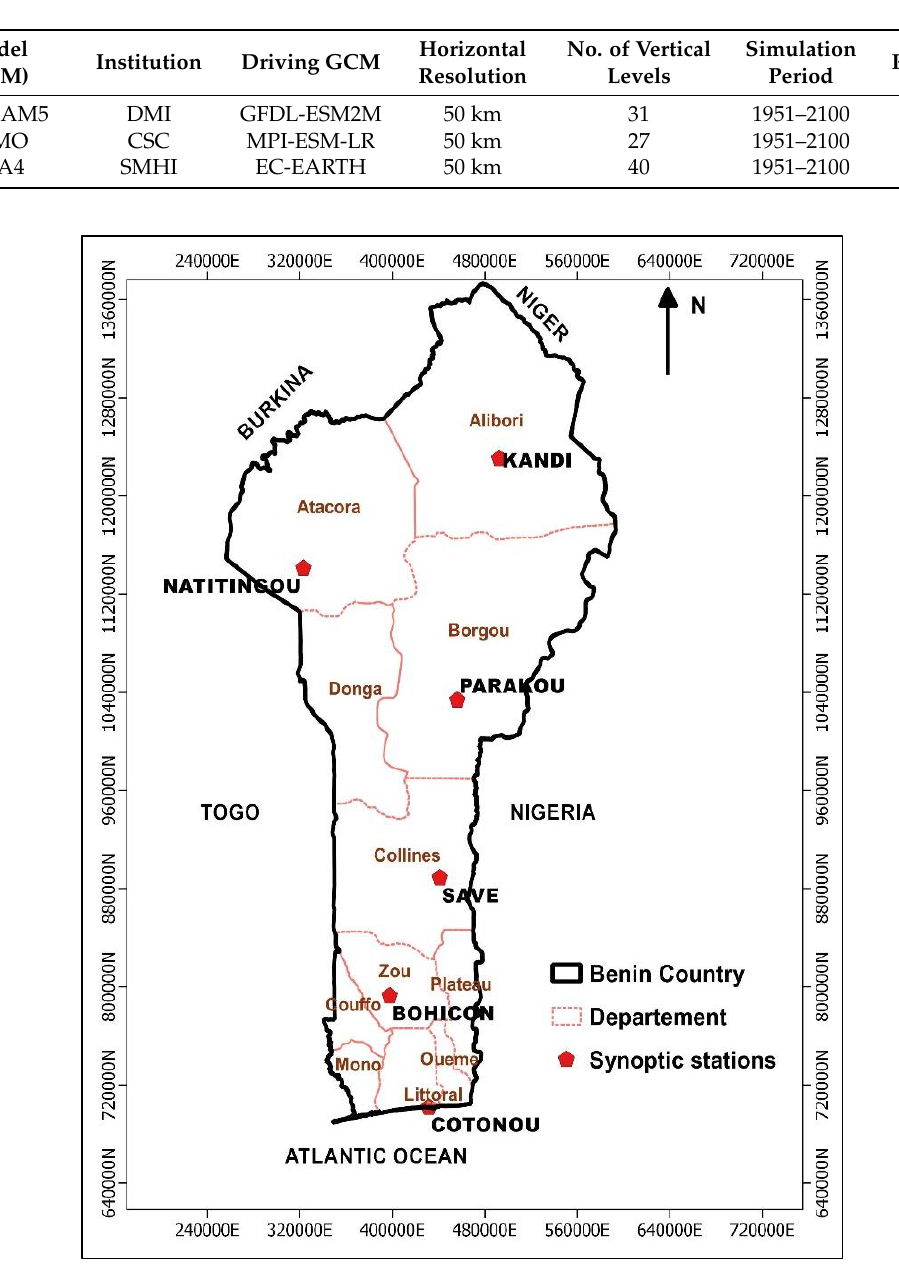
Figure 1. Study area.